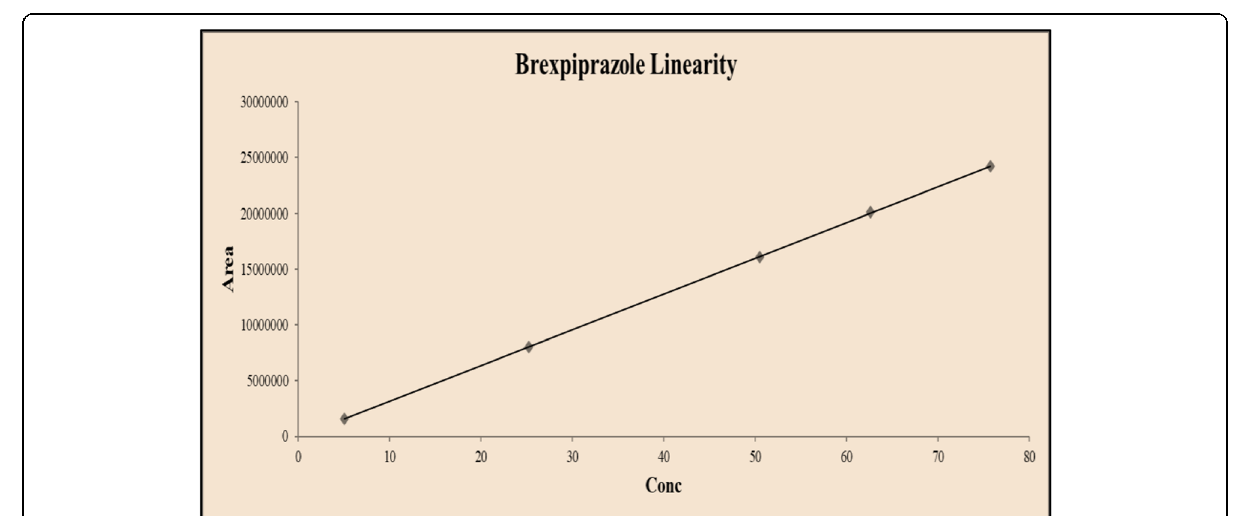
Fig. 10 Linearity graph of brexpiprazole